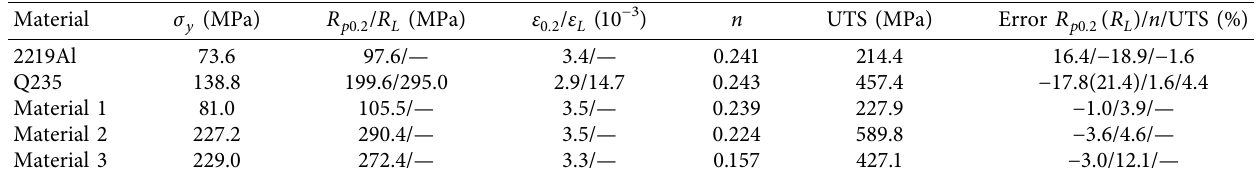
Figure 7: Comparison between experimental tensile and fitted curves of 2219Al. Table 4: Plastic properties obtained from the developed